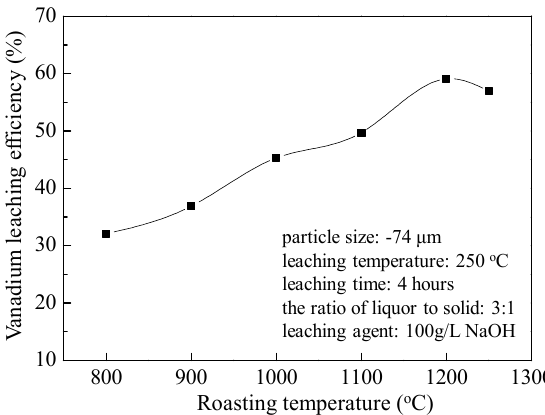
Figure 6. Effect of roasting temperature on vanadium leaching efficiency.